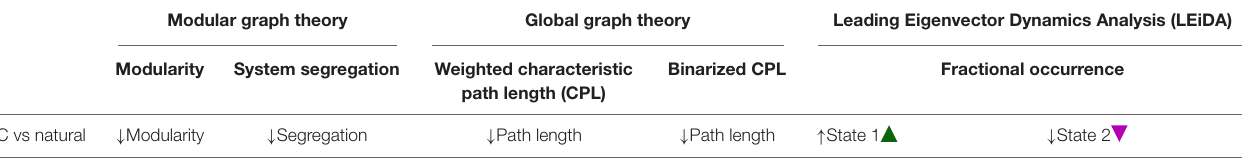
FIGURE 3 | Two brain states for k = 7 identified as having significantly elevated fractional occurrence when oral contraceptive medication is used compared to a natural menstrual cycle (A) , and opposite (B) , and summary p -values across the range of k (C) . In the connectivity visualizations, nodes are only shown if the corresponding centroid element has a strength of at least 50% of the maximum absolute loading. In panel (C) , green triangles correspond to state 1, purple triangles to state 2, and the dotted black line corresponds to the within- k Bonferroni-corrected threshold for statistical significance. TABLE 1 | Graph theory measures and state prevalence during oral contraceptive (OC) and naturally cycling state 1 and 2 are both states involving the frontoparietal